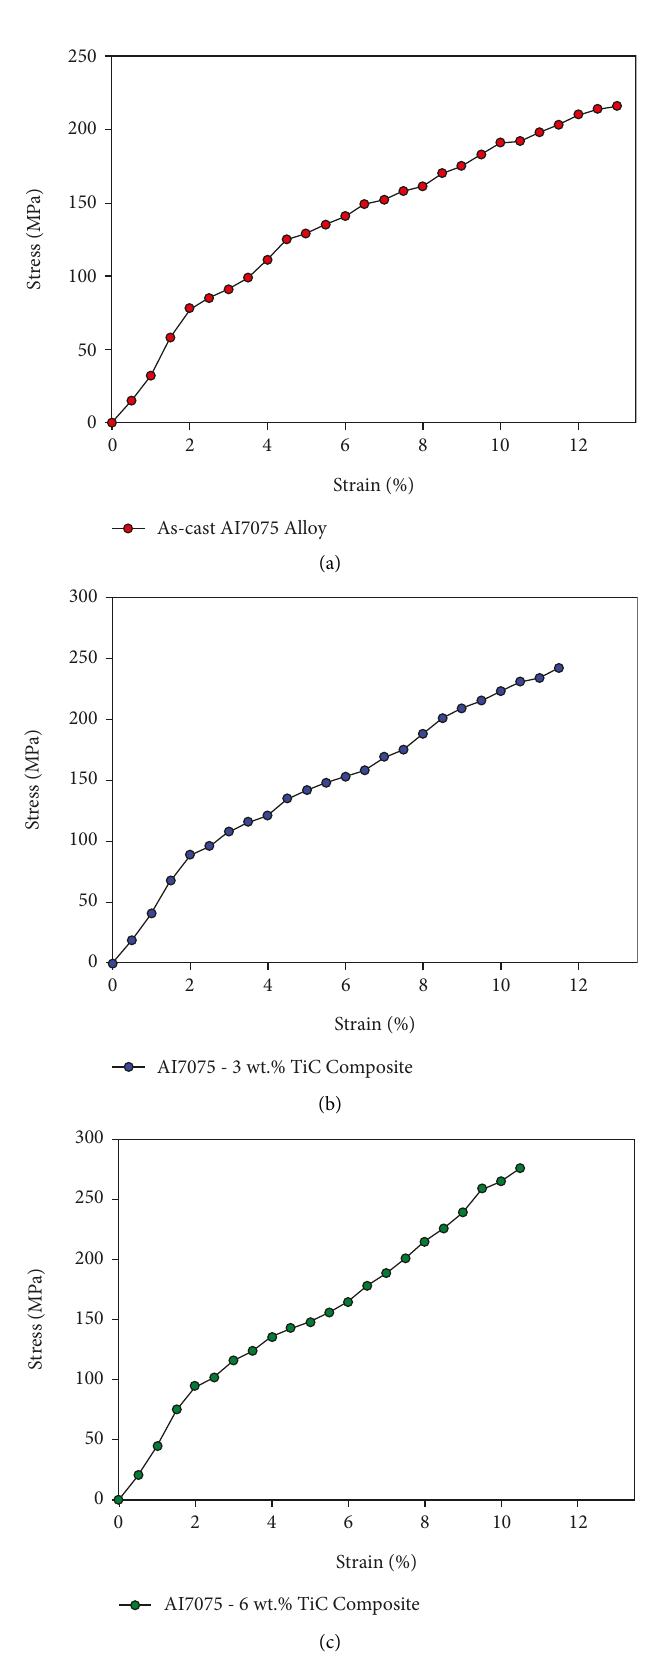
Figure 11: Stress-strain curves of (a) as-cast Al7075, (b) Al7075-3wt% TiC, and (c) Al7075-6 wt.% TiC